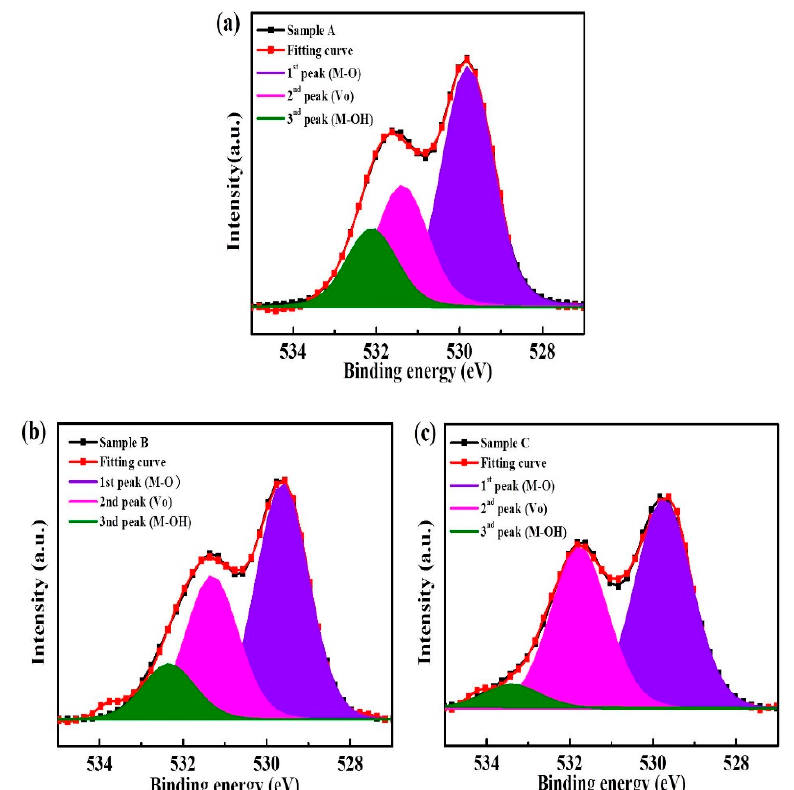
Figure 4. Fitting results of XPS spectra with O 1s peak for samples ( a ) A, ( b ) B, and ( c ) C.